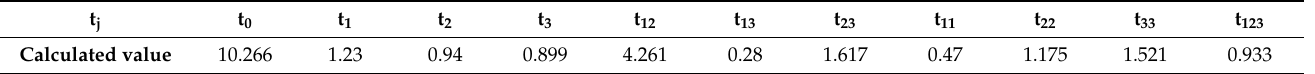
Table 5. Values of the Student’s t